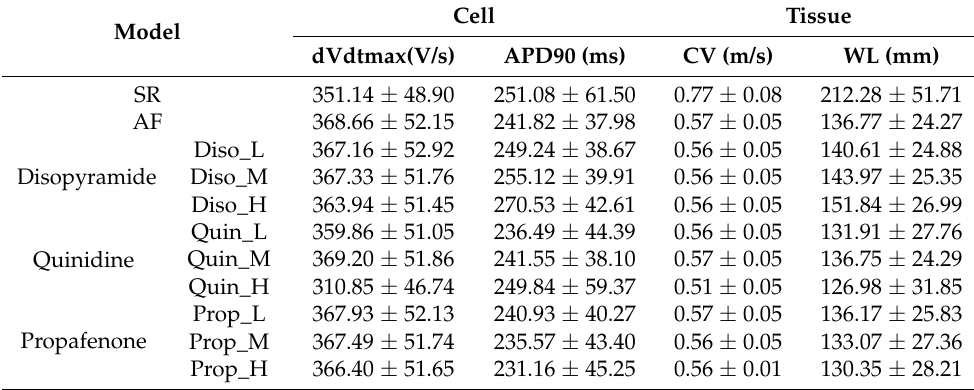
Table 7. A quantitative summary of the effects of class I antiarrhythmic drugs on human atrial electrical activity using the Grandi et al. model.